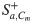
Twisted slow manifold near the folded node.A: Periodic orbit of (1) with GK = 0.04 in phase space. The default parameter setting leads to an action potential with EADs in form of a 12-MMO. B: The folded node causes a twisting of the slow manifolds and of the trajectory of (1) such that EADs occur. The attracting manifold Sa,Cm+ and the repelling manifold Sr,Cm were computed up to a surface Σ containing the folded node and transverse to the fold line F+. The red line is the projection of the trajectory from A.